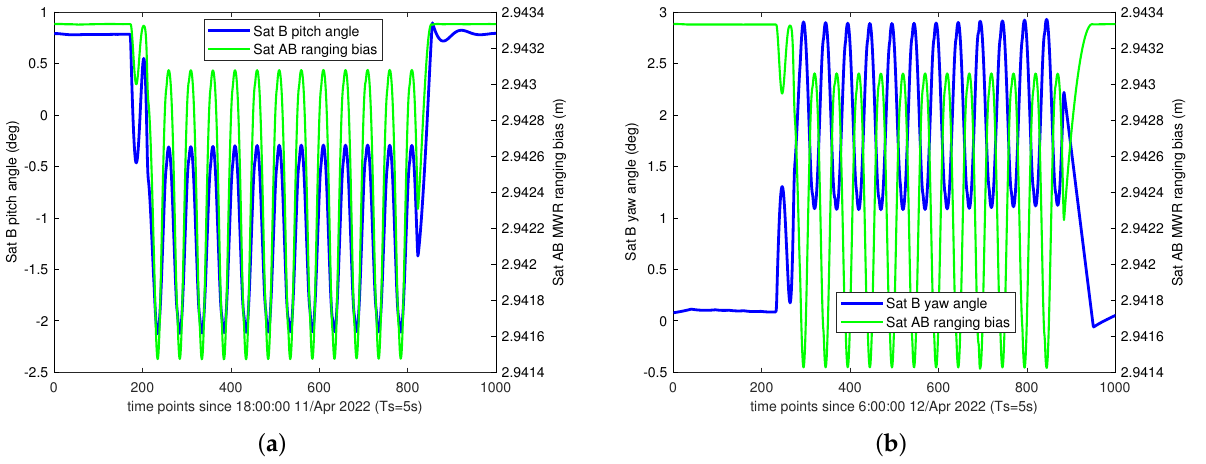
Figure 15. On-orbit attitude maneuvers for APC calibration during 11–12 April 2022. ( a ) Satellite B pitch maneuver. ( b ) Satellite B yaw